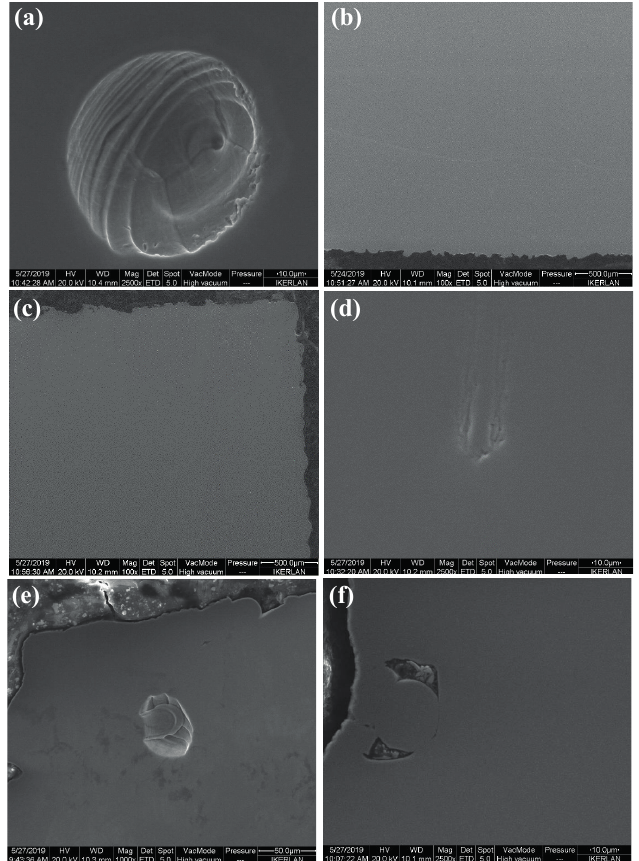
Figure 5. SEM micrographs for different laser velocities: ( a ) v = 800 mm/s, ( b ) v = 1100 mm/s, ( c ) v = 1200 mm/s, ( d ) v = 1500 mm/s, ( e ) v = 1700 mm/s, ( f ) v = 1900